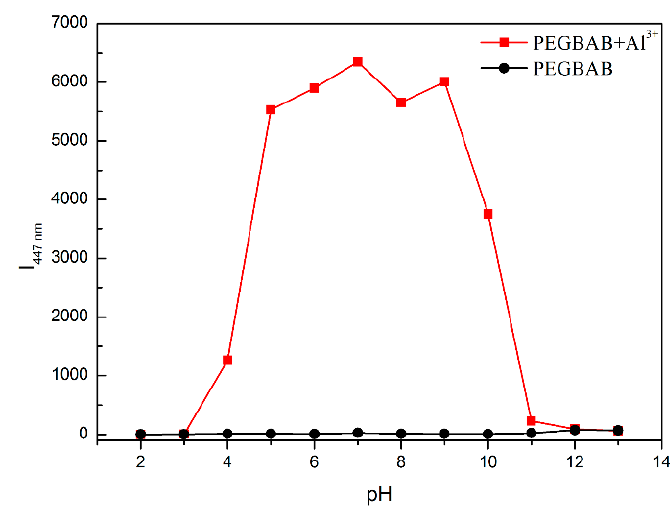
Figure 5. Effect of pH on the fluorescence intensity at 447 nm of PEGBAB (10 μ M) in aqueous solutions in the absence and presence of Al 3+ (2 equiv.).